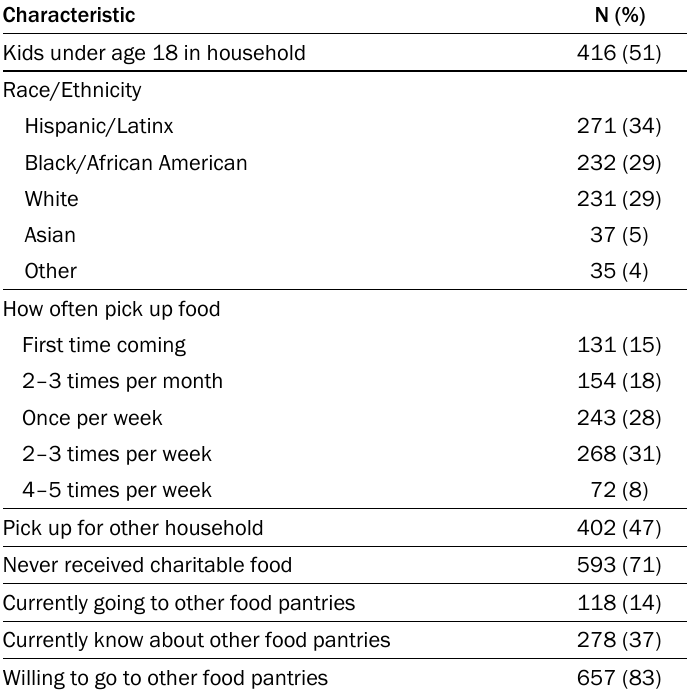
Table 2. Results of July Survey ( N